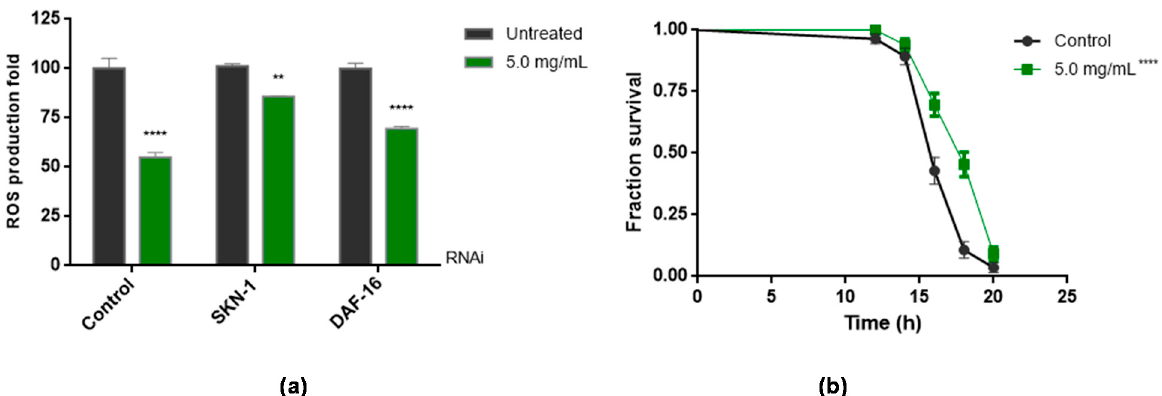
Figure 5. Effect of B. trimera leaf extract (BT) on intracellular ROS levels and oxidative stress resistance in C. elegans . ( a ) Contribution of SKN-1 and DAF-16 to ROS accumulation. RNAi animals were treated with samples at a concentration of 5 mg/mL for approximately 48 h from L1. ROS production was measured using the DCFH 2 -DA dye. Results are expressed as mean DCFH 2 -DA fluorescence levels ± SEM values. **** p < 0.0001 and ** p < 0.001, compared to the respective untreated RNAi by ANOVA, followed by Tukey’s test. ( b ) Survival curves of skn-1 (zu67) mutant animals under oxidative stress conditions. The animals were treated with 5.0 mg/mL of BT. Subsequently, they were subjected to 7.7 mM of t-BOOH. Survival was checked every 2 h **** p < 0.0001 in relation to the respective control by the Log-rank test (Mantel-Cox). Control—worms fed with the empty plasmid.